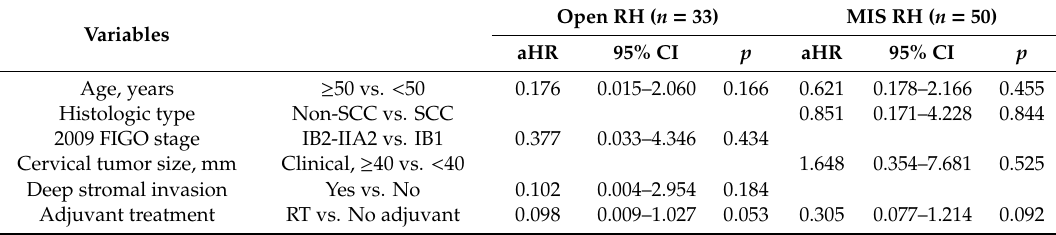
Figure 3. Survival outcomes according to surgical approach of radical hysterectomy. (Upper) Open surgery; (Lower) Minimally invasive surgery. ( A , C ) Overall survival; ( B , D ) Recurrence-free survival. Table 3. Factors associated with recurrence-free survival according to surgical approach.